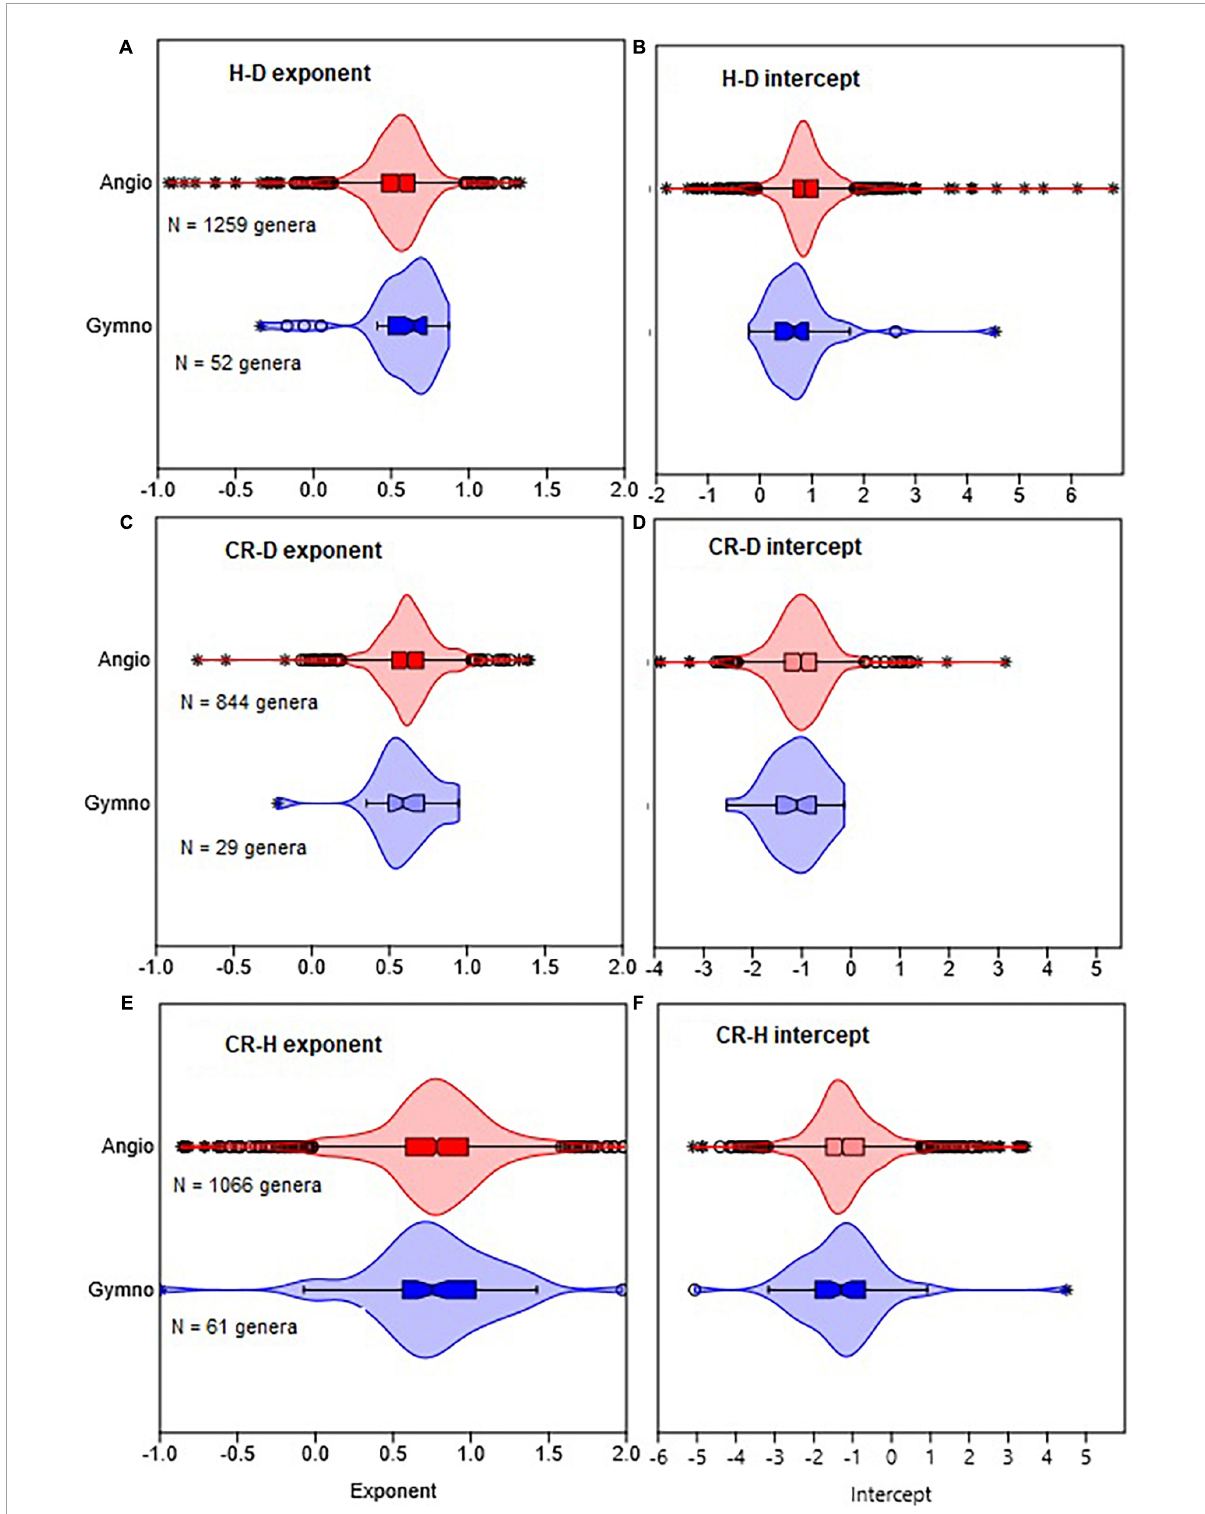
FIGURE1 Comparison of gymnosperms with angiosperms in terms of the distribution of the allometric parameters of height with stem diameter (H–D), crown radius with stem diameter (CR–D), and crown radius with stem height (CR–H) scaling. The distributions of exponents are shown in (A,C,E) , while intercepts are in (B,D,F) . The box and whisker plots display the median and its 95% CI (notches), lower quartile, upper quartile, extreme values, and outliers (O and *). Distributions in all cases are based on OLS estimates of the parameters for each